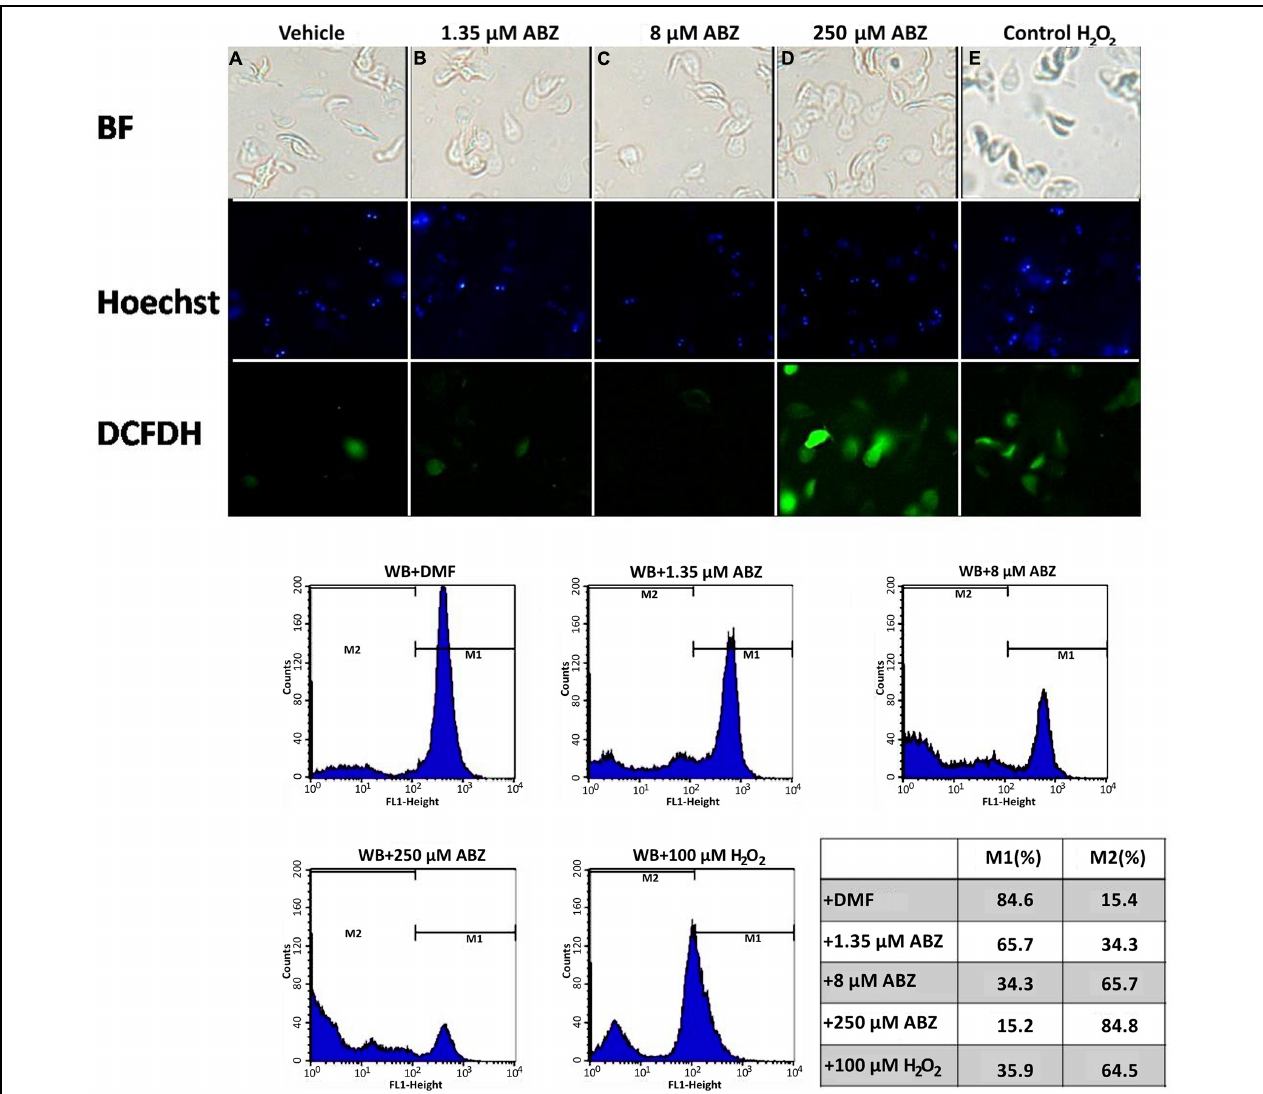
FIGURE 1 | Reactive oxygen species (ROS) are produced in Giardia duodenalis trophozoites exposed to Albendazole (ABZ). ABZ-sensitive Giardia strain (WB) was exposed to vehicle (DMF, A ) and to 1.35 μ M (B) , 8 μ M (C) , or 250 μ M (D) of ABZ for 8 h at 37 ◦ C, then DCFDH was added to monitor ROS production. In these experiments a control of intracellular ROS production was included. In this WB trophozoites were incubated with 100 μ M H 2 O 2 (E) . Trophozoites micrographs are as follows: top panels bright field (BF), middle panel trophozoites’ nuclei stained with Hoechst and lower panel trophozoites